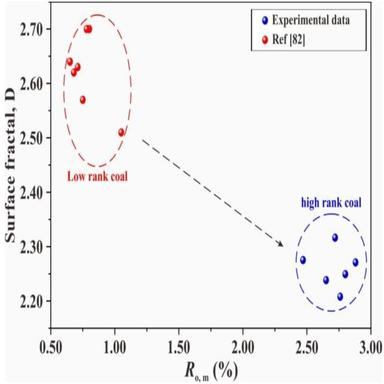
Evolution of surface fractal dimension during coalification and